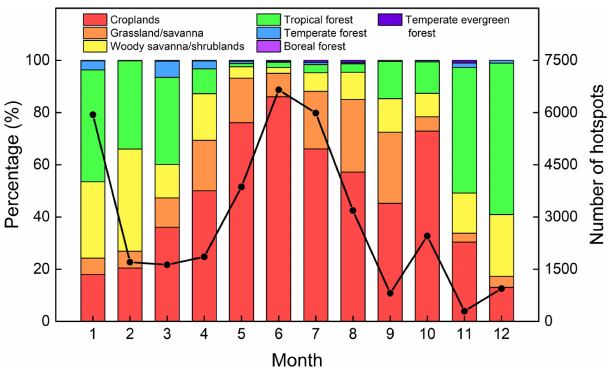
Figure 2. Monthly variations in the number of OBB fire hotspots in FINNv1.5 over CEC (right axis) in 2014 and relative contributions of seven types of OBB classified by corresponding land use types (left